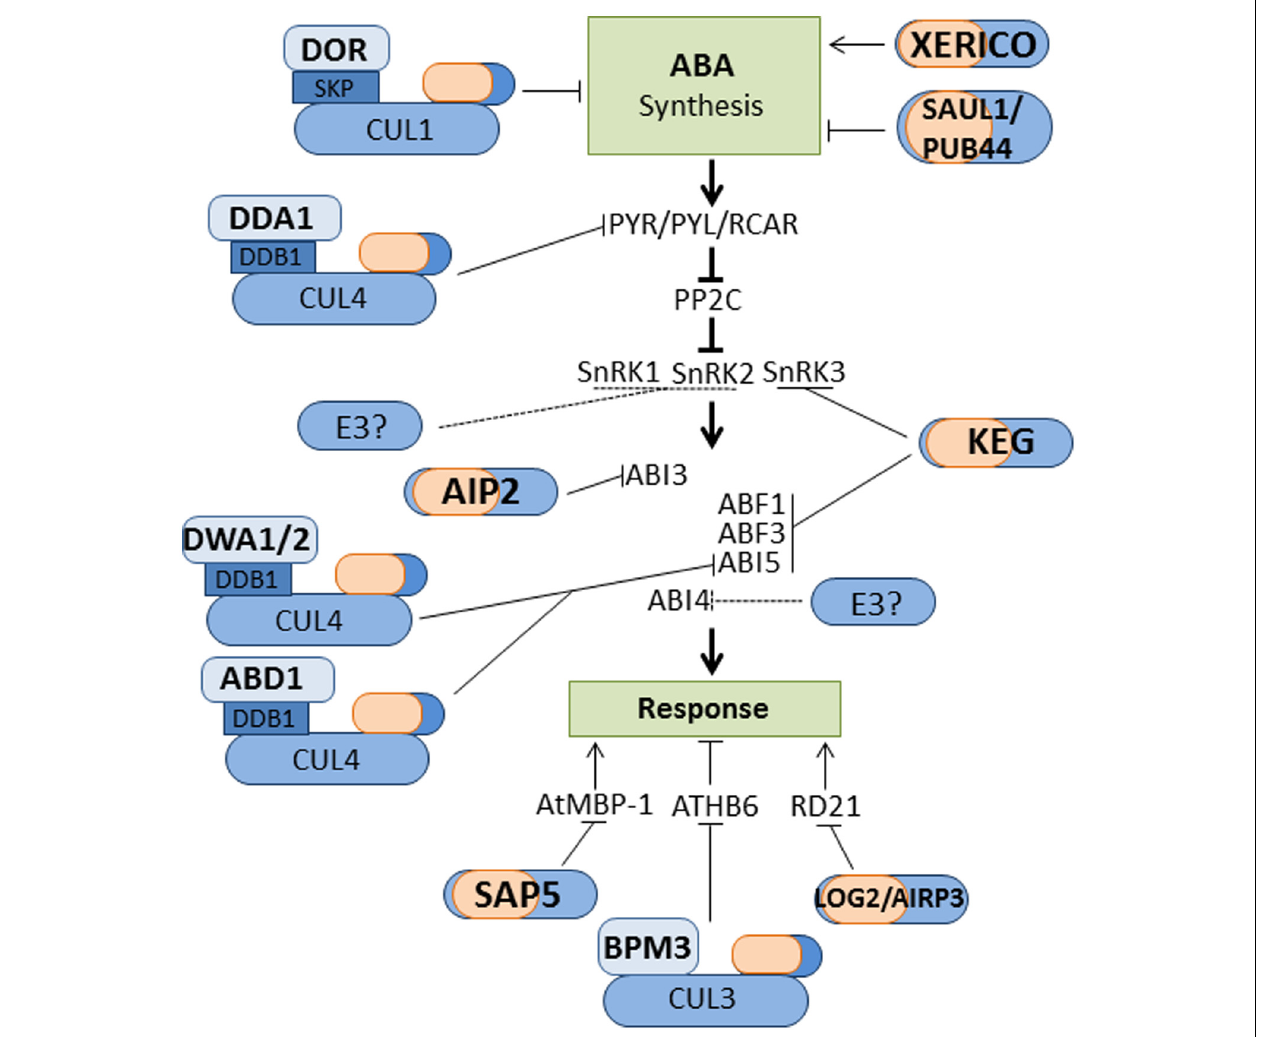
FIGURE 2 | Ubiquitin ligases that regulateABA signaling. Illustration of E3 ligases that regulate ABA synthesis, signal transduction and response. Not all E3 ligases are shown, mainly those with identified substrates. Question marks and dashed lines denote instances where proteasomal-dependent degradation is reported but the E3 ligase involved is